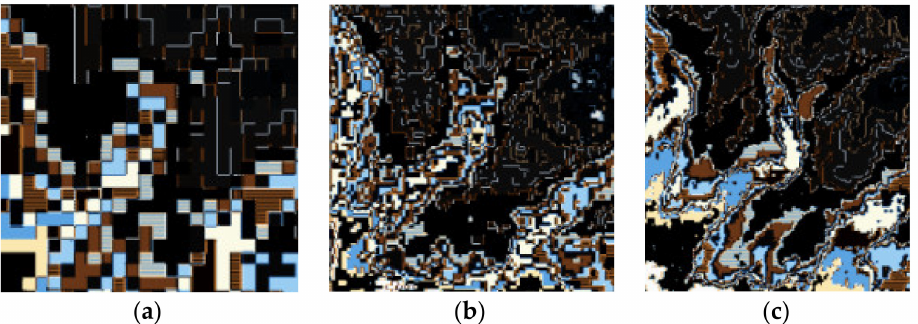
Figure 5. Different DEM resolution of alluvial fan area No. 2: ( a ) SRTM 90 m grid spacing; ( b ) ASTER GDEM DEM 30 m grid spacing; ( c ) WorldView satellites 5 m grid spacing.